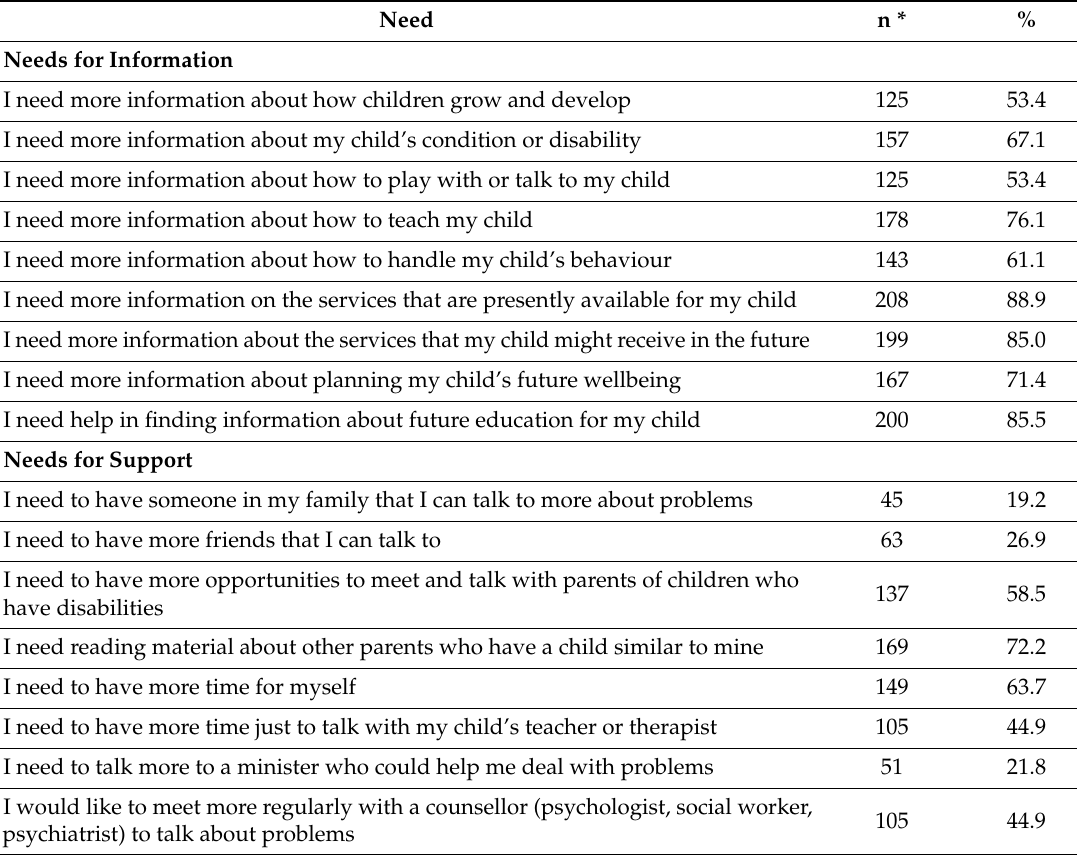
Table 6. The results of the Family Needs